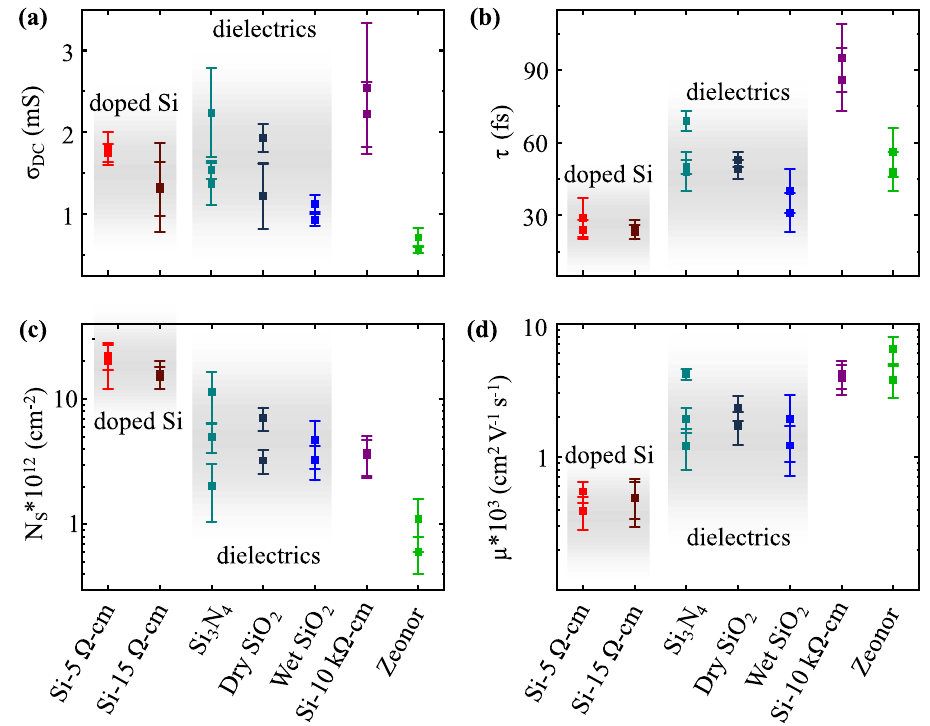
Figure 3. Results obtained for seven distinct substrates by applying the Drude fit to our experimental conductivity spectra. The calculated transport parameters are: ( a ) DC conductivity σ DC , ( b ) scattering time τ , ( c ) carrier density N S , and ( d ) mobility μ . Solid squares represent the average value measured across several spots on a sample. Error bars represent one standard deviation. Measurements are repeated at least twice for each sample on a different day under similar experimental conditions.